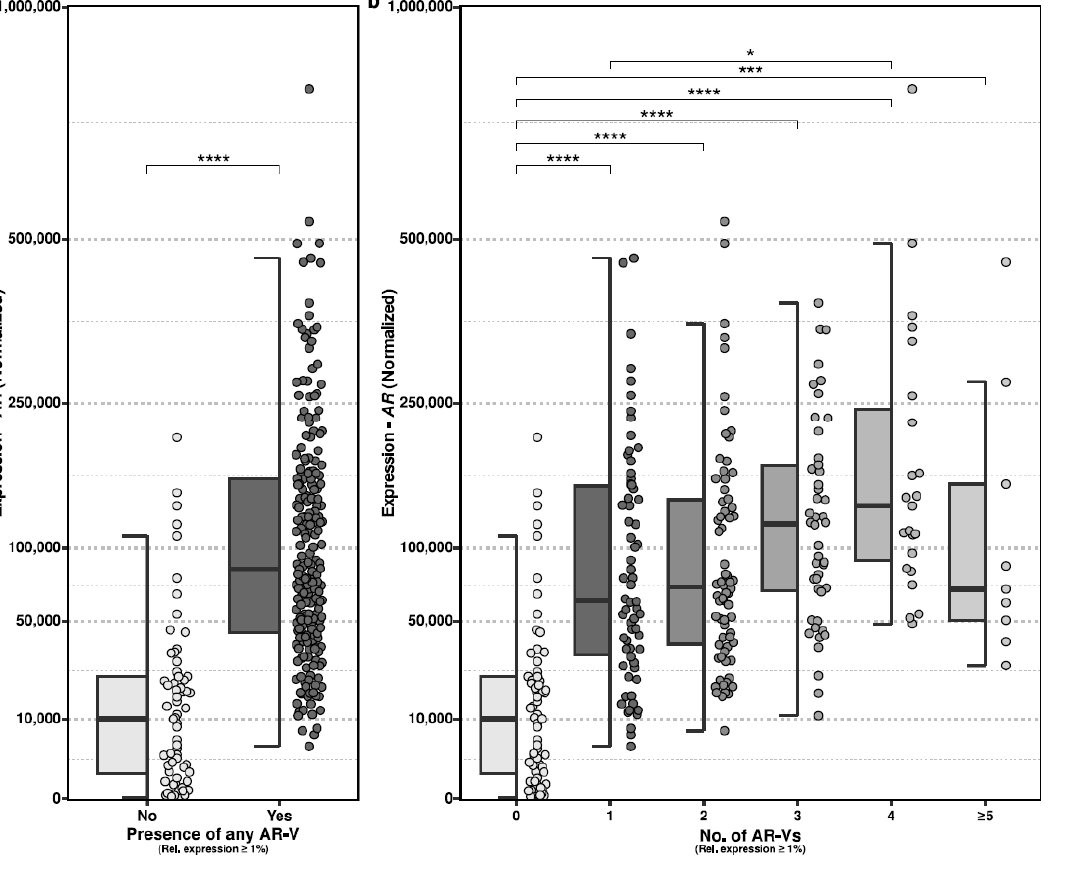
Figure 2. Presence of AR-Vs compared to expression of AR. 9. Normalized expression of AR ( y -axis; square-root transformed) between mCRPC samples (CPCT-02) with and without expression of any